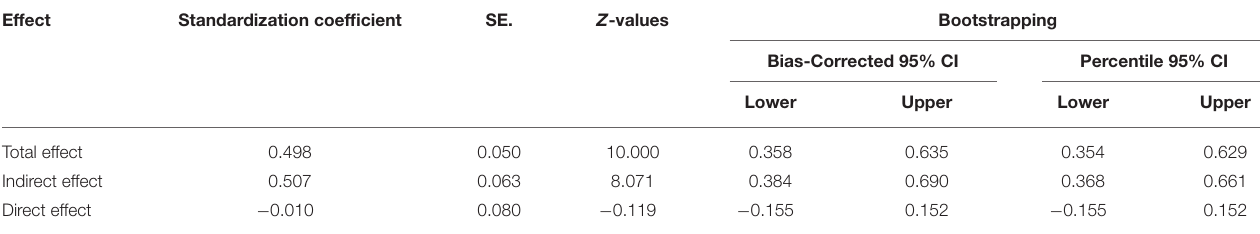
TABLE 6 | The mediating effect of affective